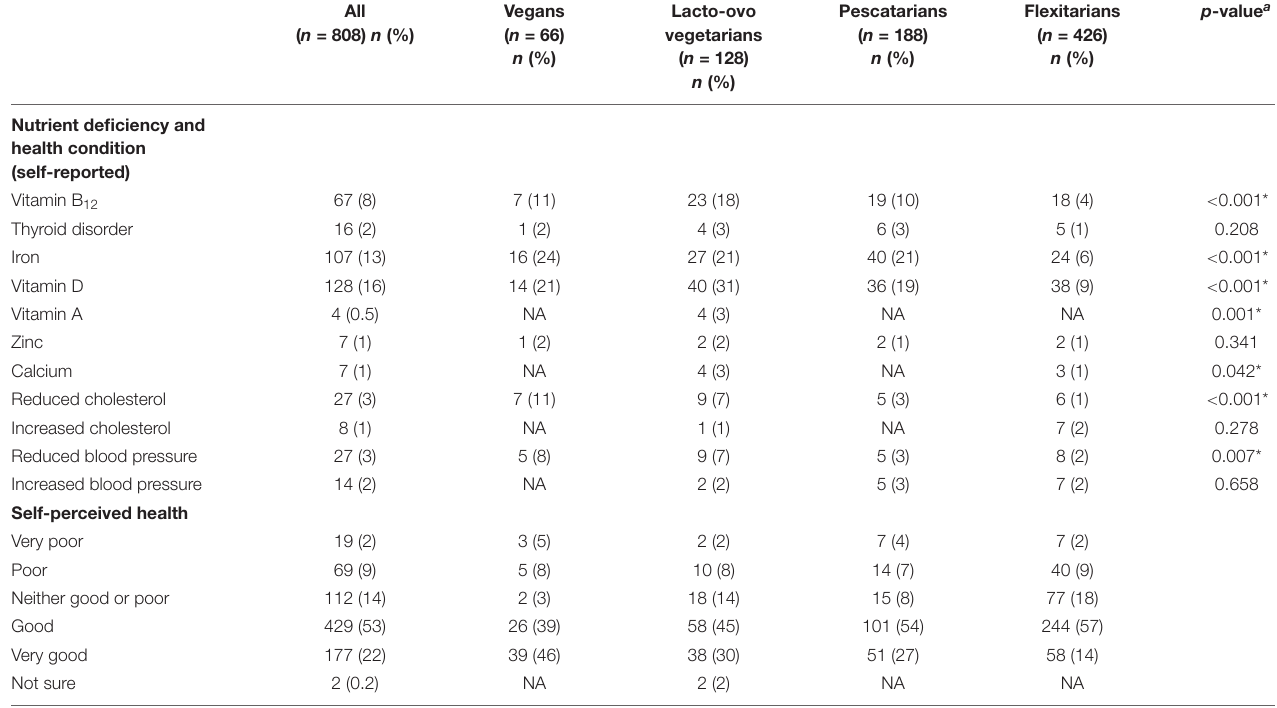
TABLE 4 | Self-reported nutrient deficiency and health conditions, and self-reported health among adults adhering to different plant-based diets in Norway ( n = 808).